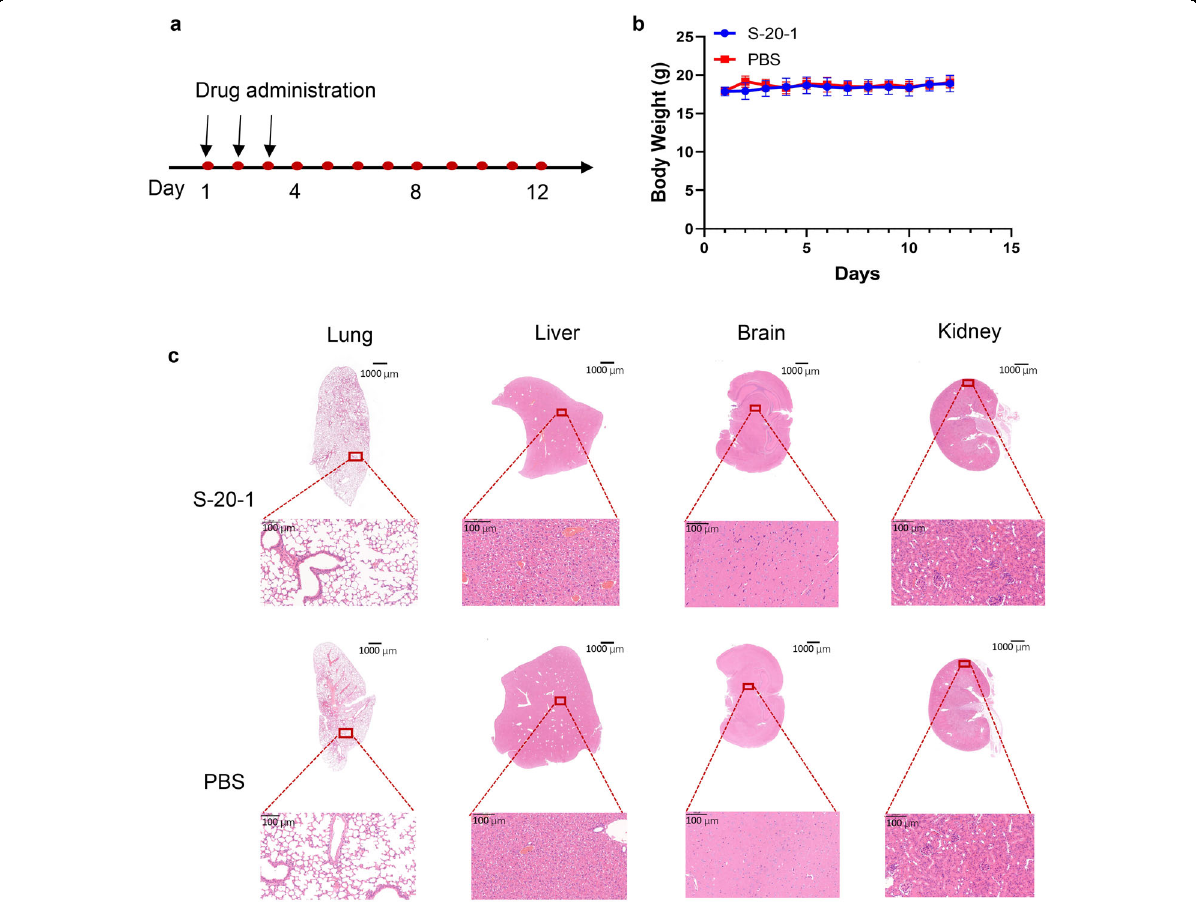
Fig. 9 In vivo safety evaluation of S-20-1. a Flow diagram of in vivo safety experiments. b Body weight changes of mice administered with S-20-1 or PBS intranasally. c Histological changes of mouse lung, liver, brain, and kidney after administration with S-20-1 or PBS intranasally. Tissues were stained with H&E. The scale bar shown in slides were 1000 µm and 100 µm,